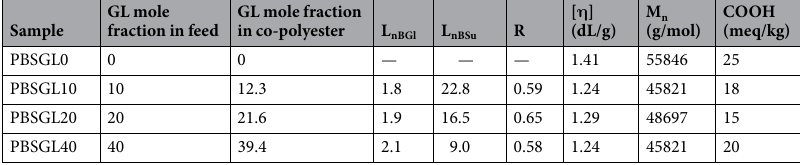
Table 1. Characteristics and 1 HNMR results of the synthesized